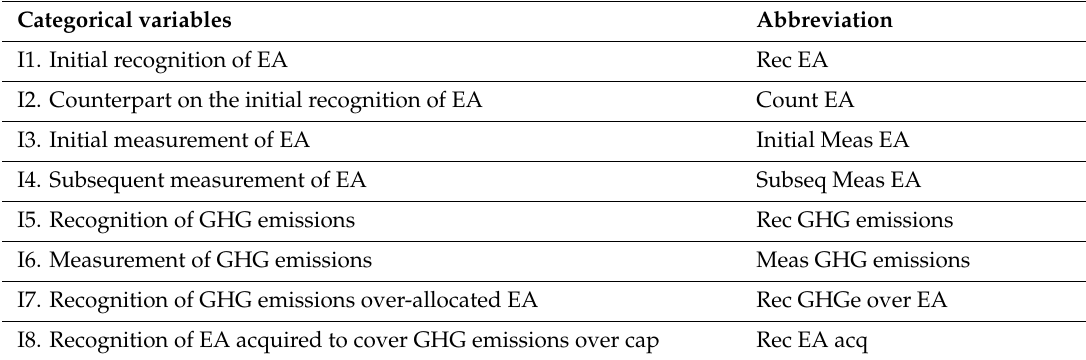
Table 2. Variable